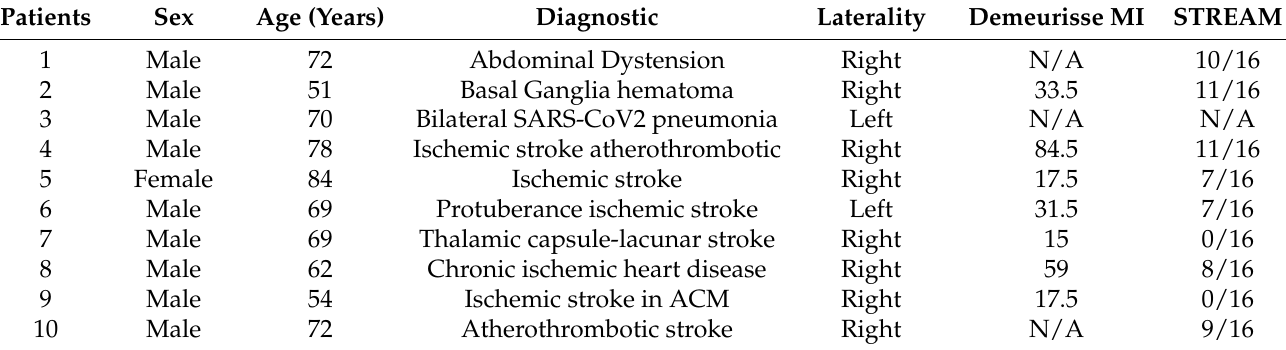
Table 1. Information of the patients.